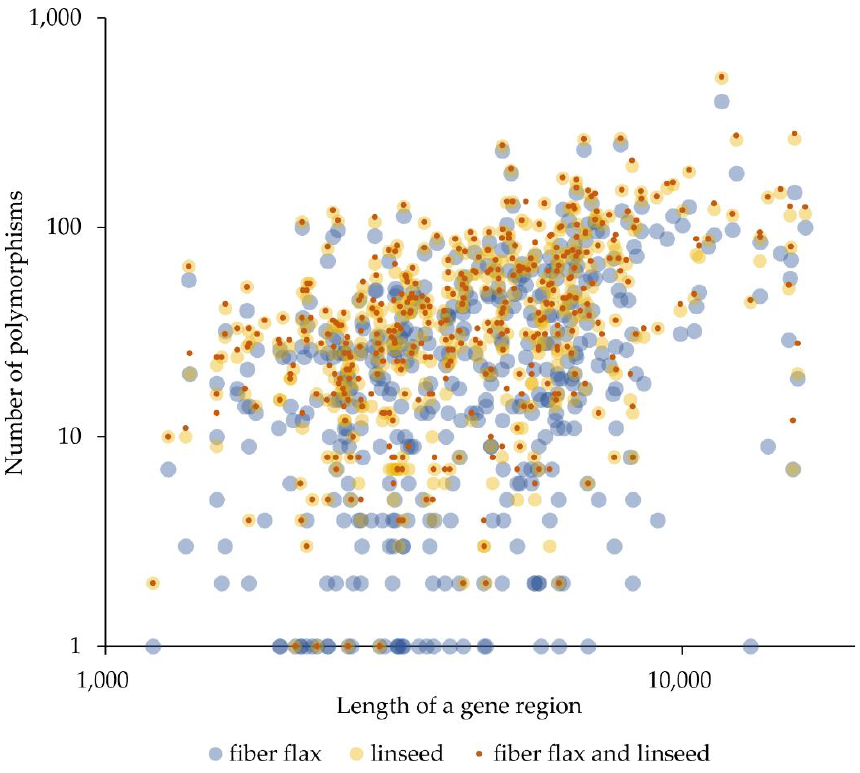
Figure 1. Data on the number of polymorphisms for individual genes of the 4CL , C 3′ H , C4H , CAD , CCR , CCoAOMT , COMT , F5H , HCT , PAL , CTL , BGAL , ABC , HMA , DIR , PLR , UGT , TUB , CESA , RGL , FAD , SAD , and ACT families taking into account the length of the analyzed region (gene length + 1000 bp, 500 bp upstream and 500 bp downstream).